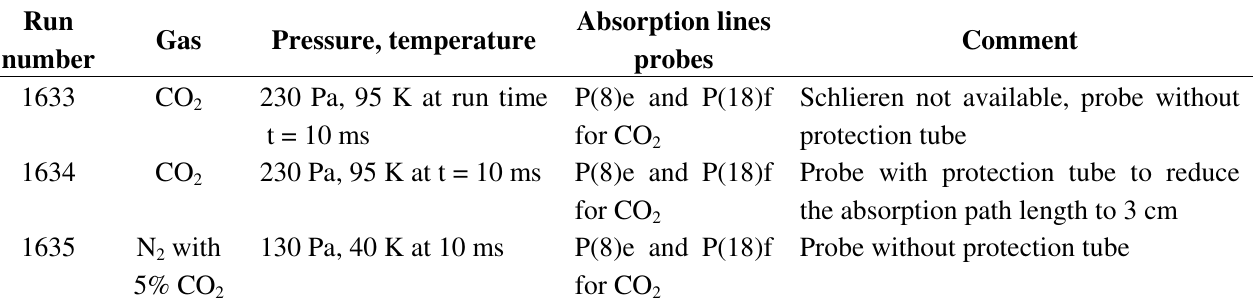
Table 1. VKI wind tunnel flow conditions and parameters used for TDLAS.